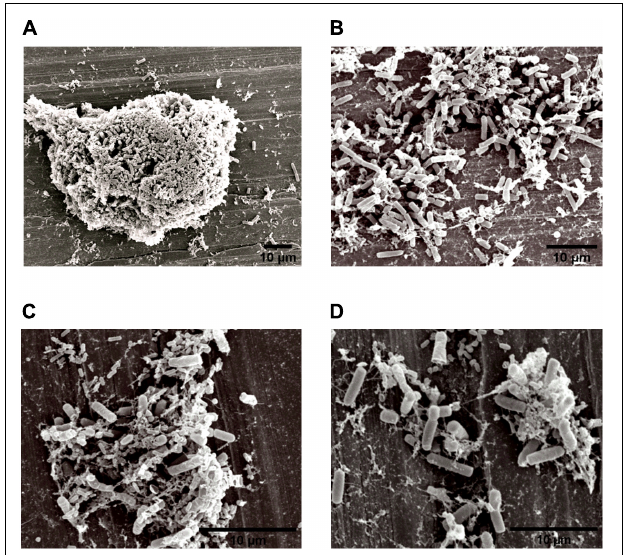
FIGURE 4 | Image obtained by SEM (JEOL) of the interaction between L. monocytogenes and B. cereus in the biofilm on stainless steel (Experiment 1, Group 3). Agglomerates of dual-species biofilms (A) ; Biofilm cells (B,C) ; and low EPS production (D) .